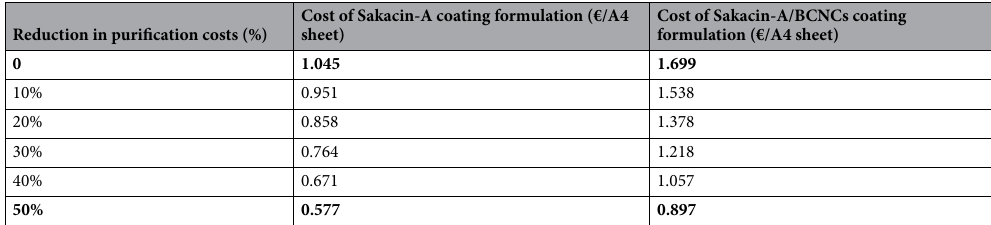
Table 4. Simulation of change in active formulations costs for decreasing levels of purification costs. Lab scale costs (first row) and simulated pilot/plant scale costs (last row) are denoted in